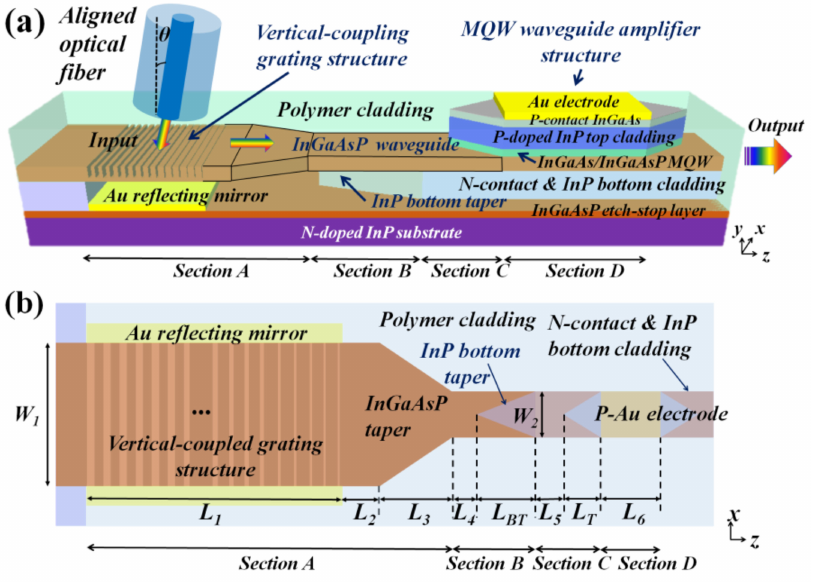
Figure 1. ( a ) The geometry of the proposed photonic device integration scheme with 4 separate sections. ( b ) X-Z cross-sectional profile of the 4